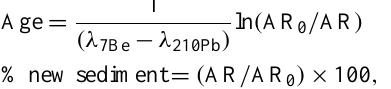
Fig. 2. Discharge measurements for the Tana River (2008–2010) as recorded at Garissa station (data source: Water Resource Manage- ment Authority). Brace brackets indicate the duration of the three field